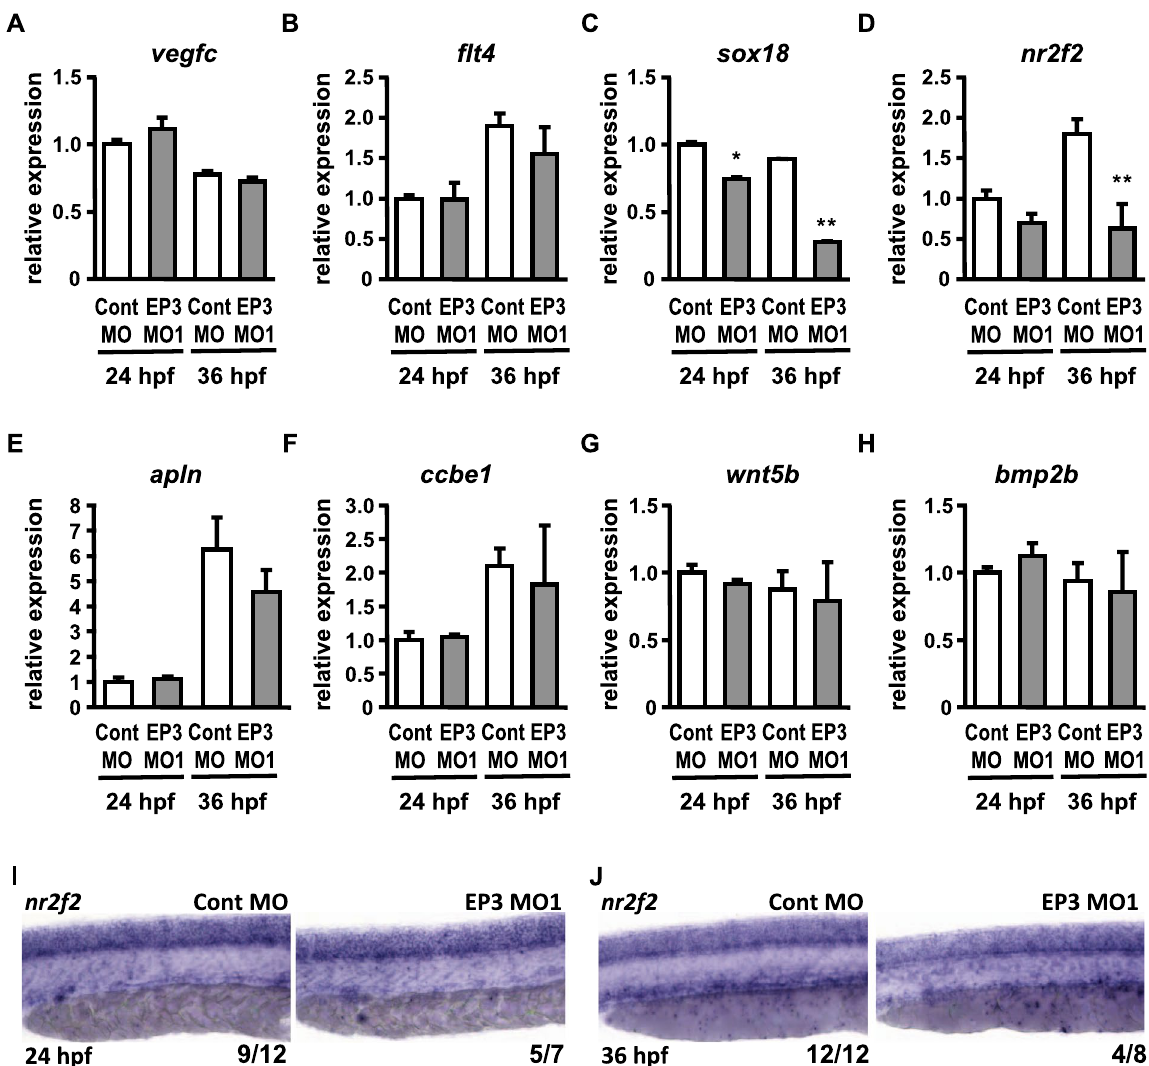
Figure 3. Expression of genes involved in lymphatic specification. ( A – H ) Relative expression levels (at 24 and 36 hpf) of genes involved in lymphatic specification were quantified by RT-qPCR in morphants injected with Cont MO or EP3 MO1. Values are shown relative to the value obtained with Cont MO at 24 hpf. Each value represents the mean ± SEM (N = 3). * P < 0.05, ** P < 0.01 vs Cont MO at each corresponding time. ( I , J ) Expression of nr2f2 was analyzed by WISH in morphants at 24 and 36 hpf. The number at the bottom right of each panel indicates the number of embryos demonstrating the phenotype shown in the panel over the total number of embryos analyzed in a representative